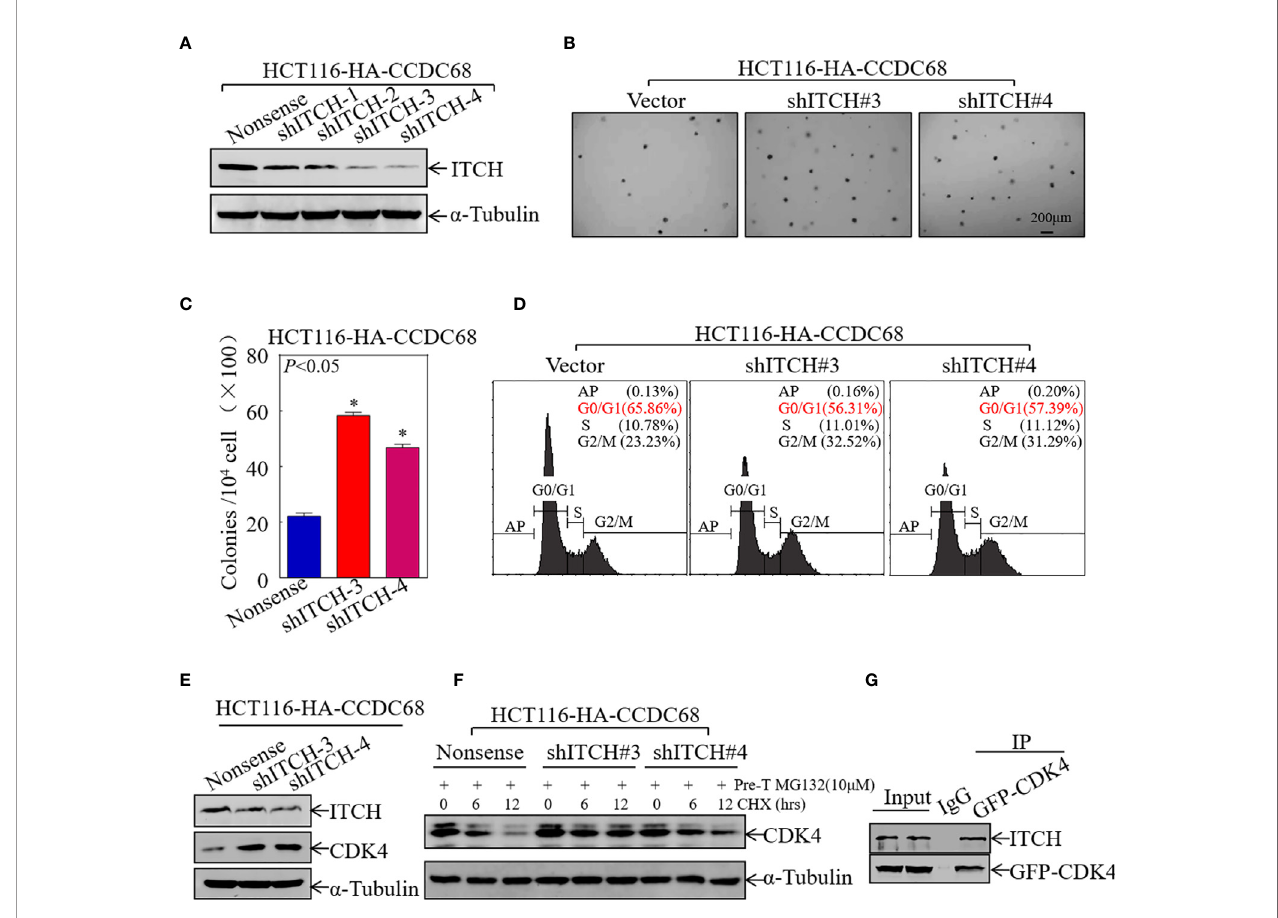
FIGURE 6 | CCDC68 accelerates the degradation of CDK4 by regulating ITCH expression. (A) Western blotting analysis of the ef fi cacy of HCT116 (CCDC68) transfection with shITCH lentivirus or Nonsense lentivirus. (B, C) HCT116 (CCDC68/shITCH#3, #4) and HCT116 (CCDC68/Nonsense) cells were tested for anchorage-independent growth. Cell colonies were counted, and the results are presented in the diagram. Data are presented as the mean ± SD and analyzed by Student ′ s t -test, * P < 0.05. (D) Analysis of HCT116 (CCDC68/shITCH#3, #4) and HCT116 (CCDC68/Nonsense) cell cycles by fl ow cytometry. (E) Western blotting analysis of CDK4 levels in HCT116 (CCDC68/shITCH #3 and #4), and HCT116 (CCDC68/Nonsense) cells. (F) Effect of ITCH knockdown on CDK4 degradation rate in HCT116 (CCDC68) cells detected by western blotting. (G) The interaction between CDK4 and ITCH was analyzed by co-immunoprecipitation in 293T cells transfected with the GFP-CDK4